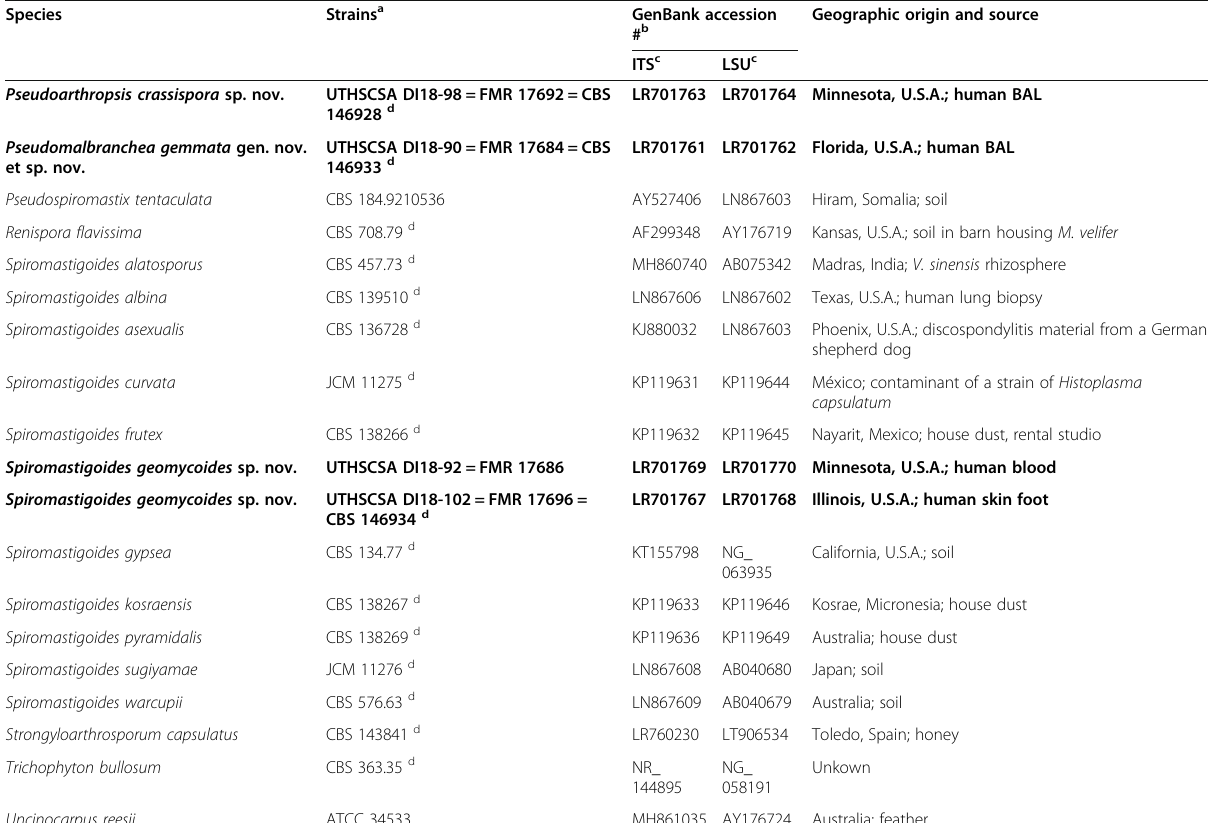
Geographic origin and source # b ITS c